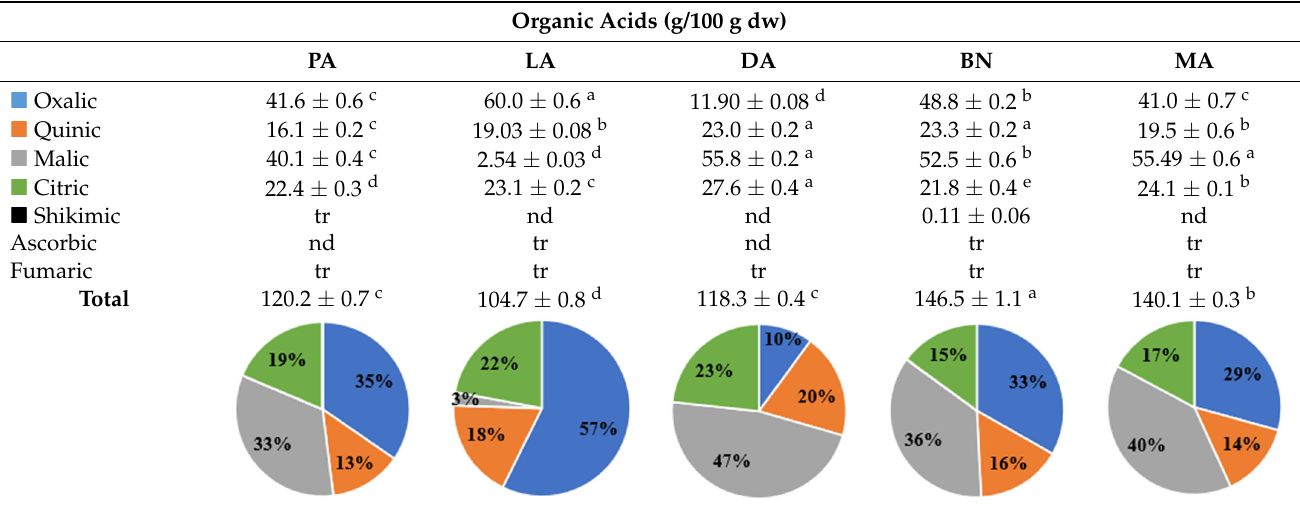
Table 2. UFLC-DAD characterization of organic acids composition in fig leaves. Organic Acids (g/100 g